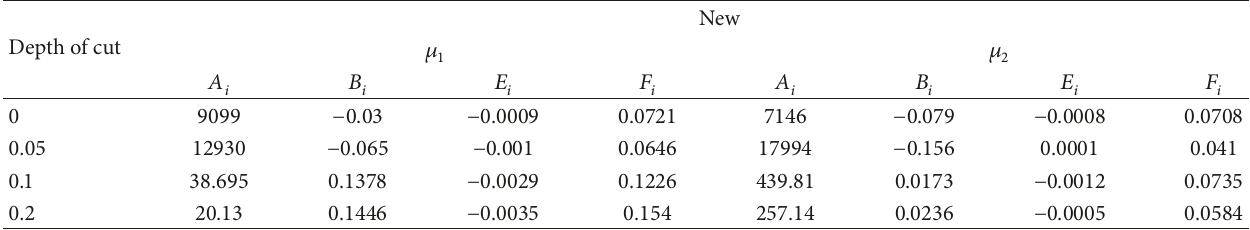
Table 6: Values of the parameter’s constants of the friction coefficient functions, in the case of the new insert. Depth of cut